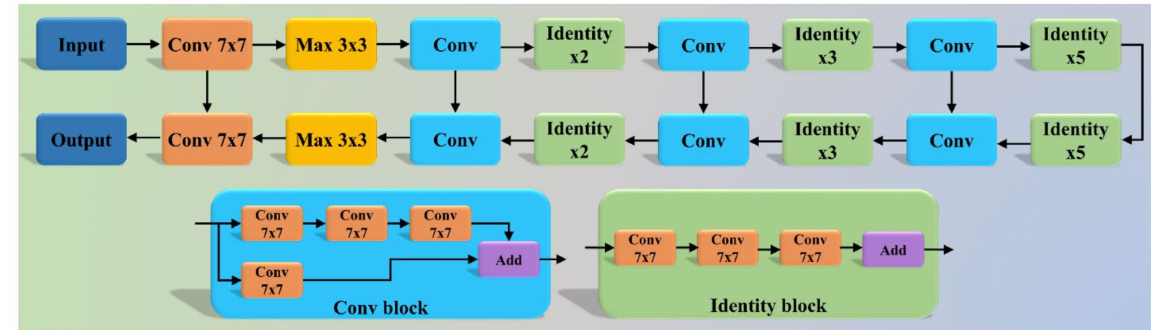
Figure 4. VGG-SegNet (HDL 1) architecture.